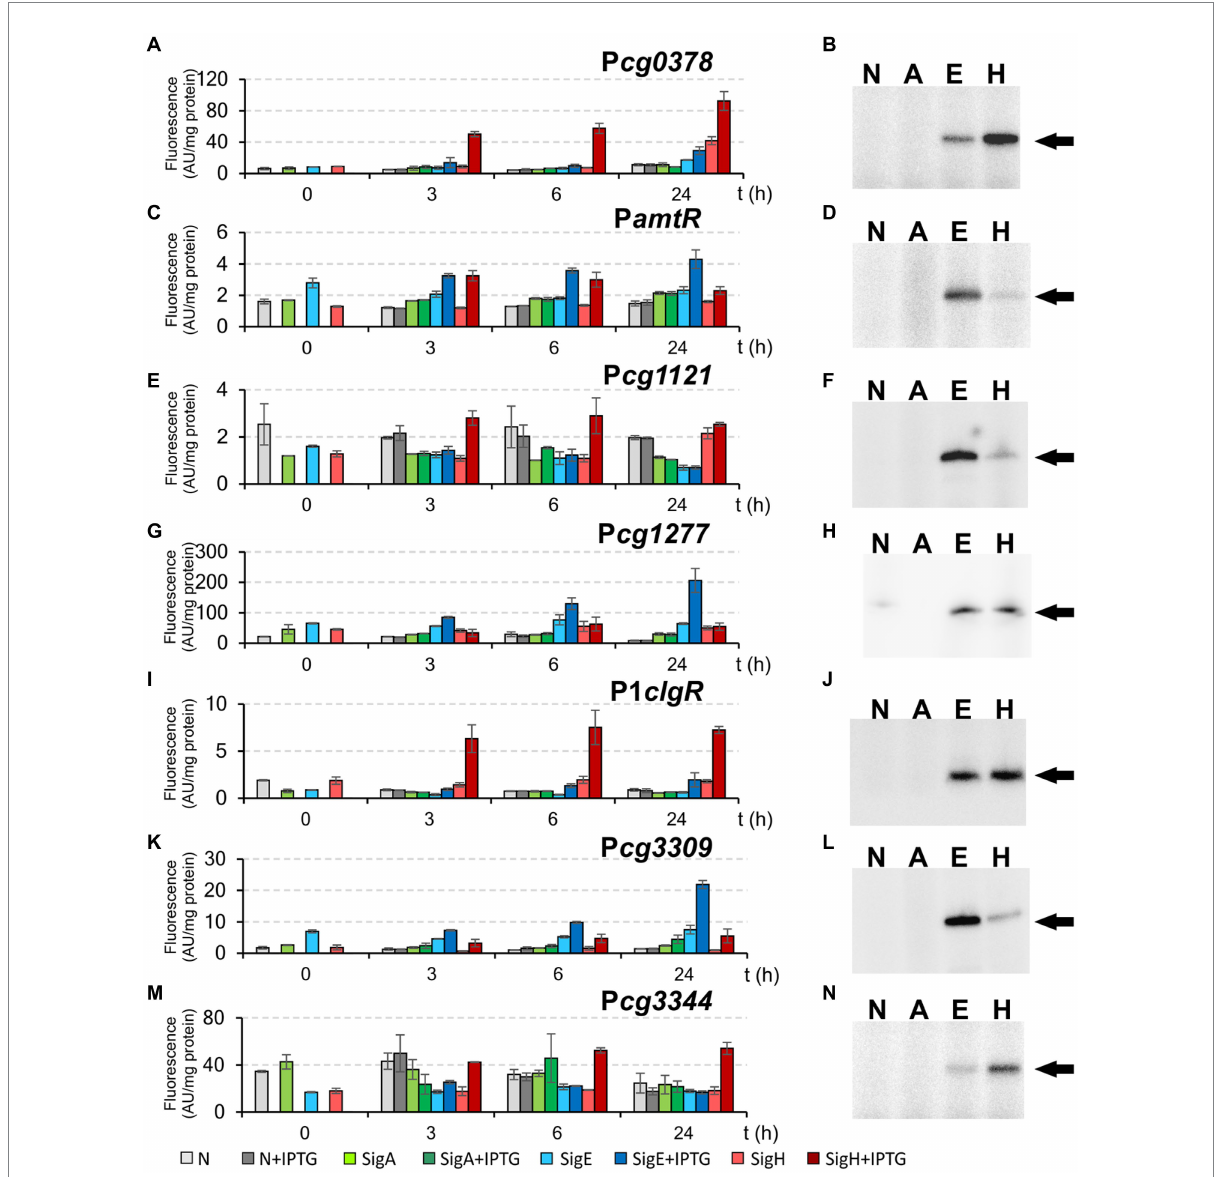
FIGURE 7 Activity of σ Η / σ E -dependent promoters P cg0378 , P amtR , P cg1121 , P cg1277 , P1 clgR , P cg3309, and P cg3344 determined by in vivo two-plasmid system (A,C,E,G,I,K,M) and in vitro transcription (B,D,F,H,J,L,N) . The two-plasmid C. glutamicum strains carried the pEC-XT99A constructs overexpressing sigA , sigE, or sigH after IPTG addition (at time point 0) and the promoter-test vector pEPR1 carrying the reporter gfp uv gene downstream of the tested promoters. The strains carrying pEPR1 with the tested promoters and empty pEC-XT99A were used as the controls (gray bars). The fluorescence intensity of cultures without IPTG is shown as light bars; the fluorescence intensity of cultures with IPTG induction is shown as dark bars. AU, arbitrary units. The standard deviations of three biological replicates are depicted as error bars. Sigma factors (A, E, H; N = no sigma) used for in vitro transcription are shown above the autoradiograms ( B,D,F,H,J,L,N) . The specific transcripts are indicated by arrows. The result of in vitro transcription with P1 clgR shown in panel J ( in vitro transcription with P1 clgR ) is the same as we published previously (Šilar et al.,